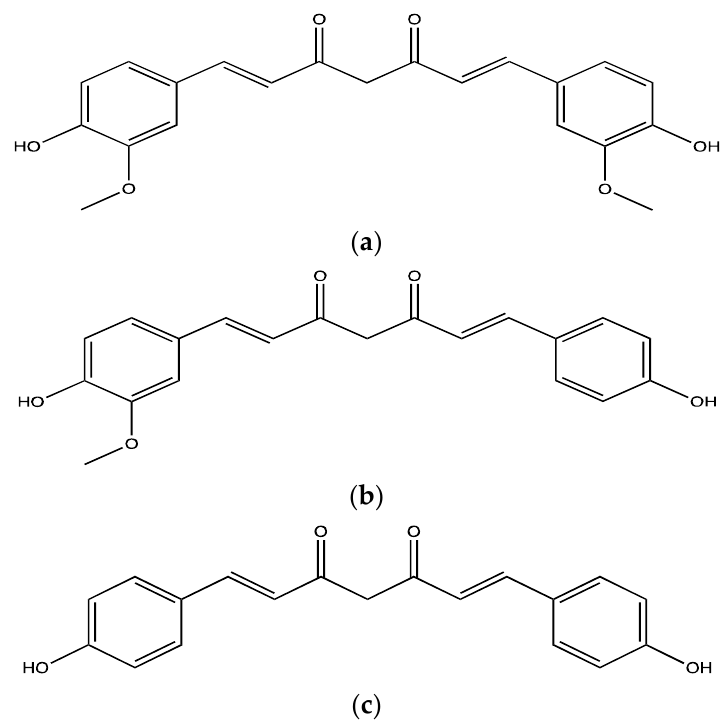
Figure 12. Structure of curcuminoids: ( a ) curcumin, ( b ) demethoxycurcumin; ( c ) bisdemethoxycur- cumin isolated from C. longa.